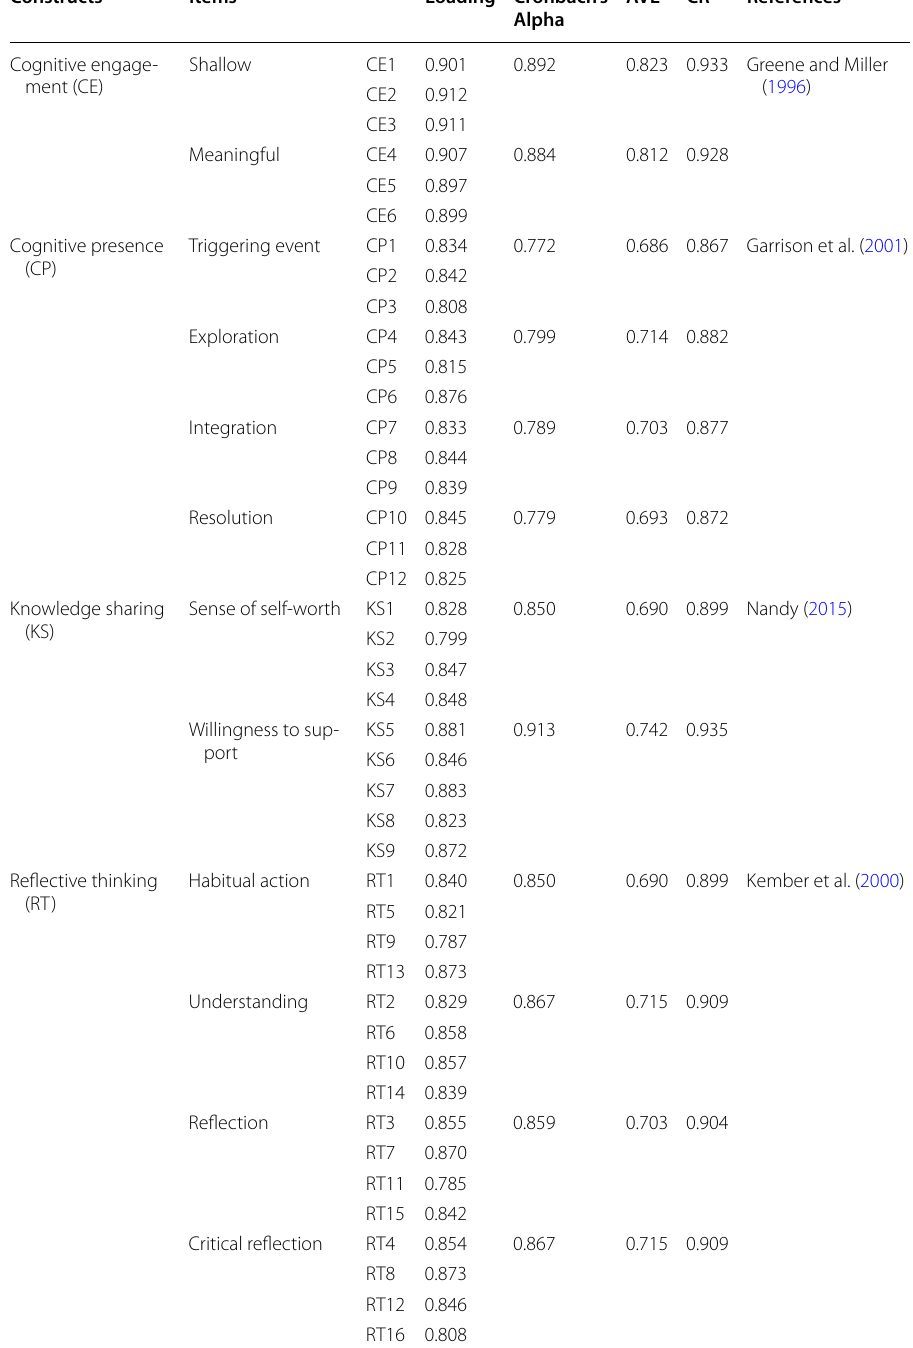
Table 3 Construct and measurement model